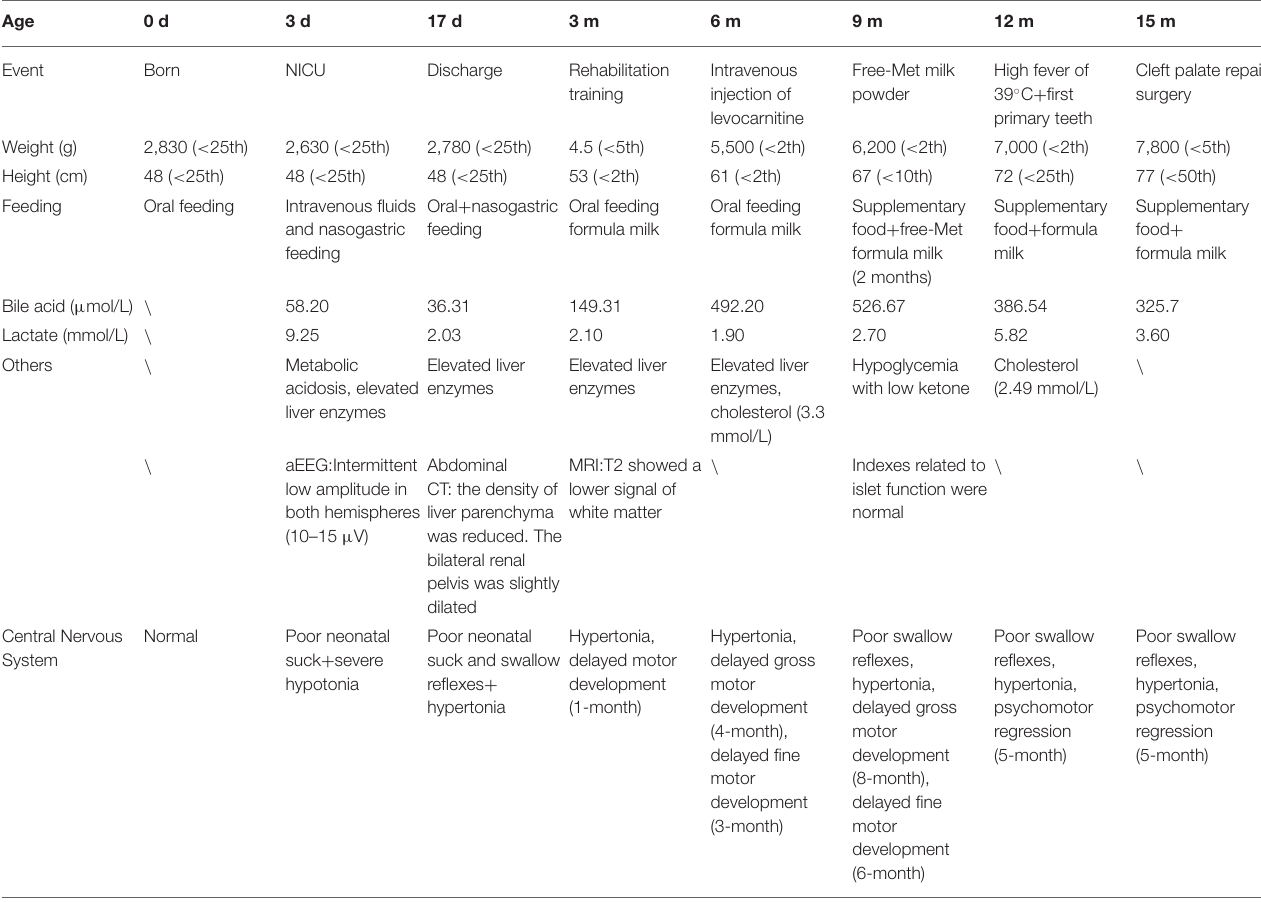
TABLE 1 | Follow-up of the infant from birth to 15 months of